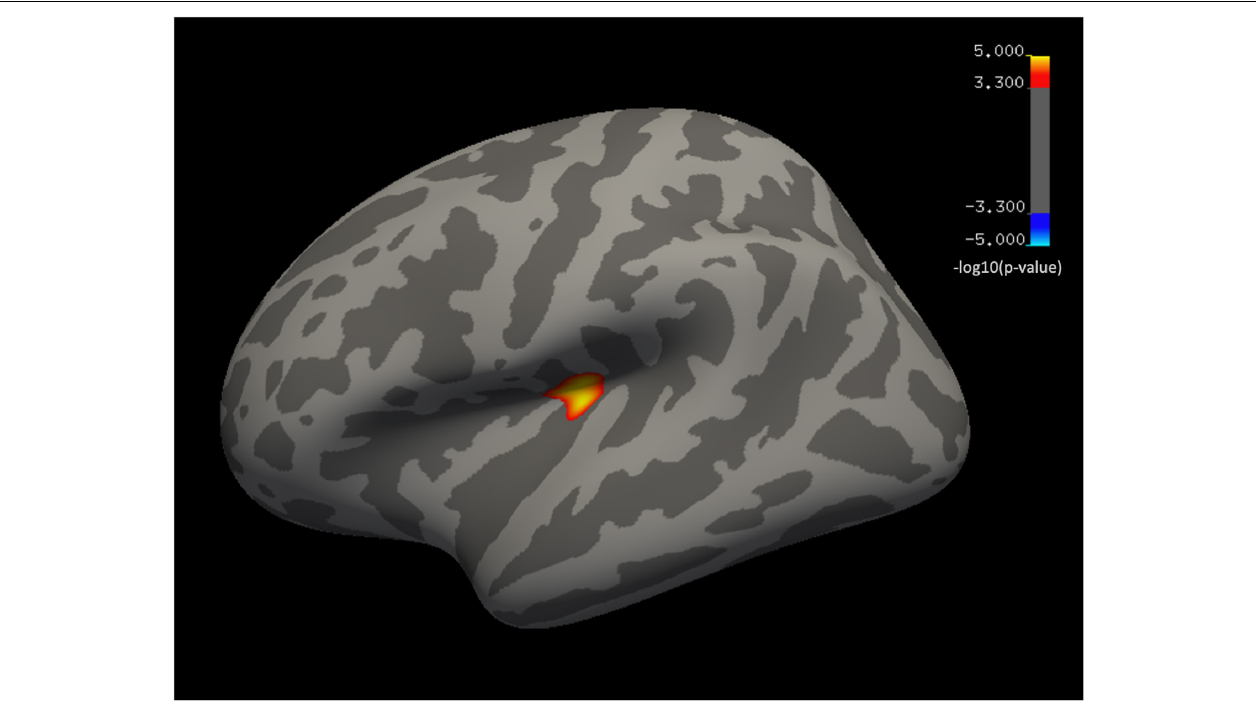
FIGURE 2 | Whole-brain vertex-wise analysis. Inflated cortical convolution maps showing group differences in a cluster located in the left insula, corrected for multiple comparisons (cluster-forming threshold p < 0.0005 and cluster-wise p-threshold < 0.05). Significance levels are on a -log(p) scale; positive values reflect the larger surface area in BDs vs. controls (warm